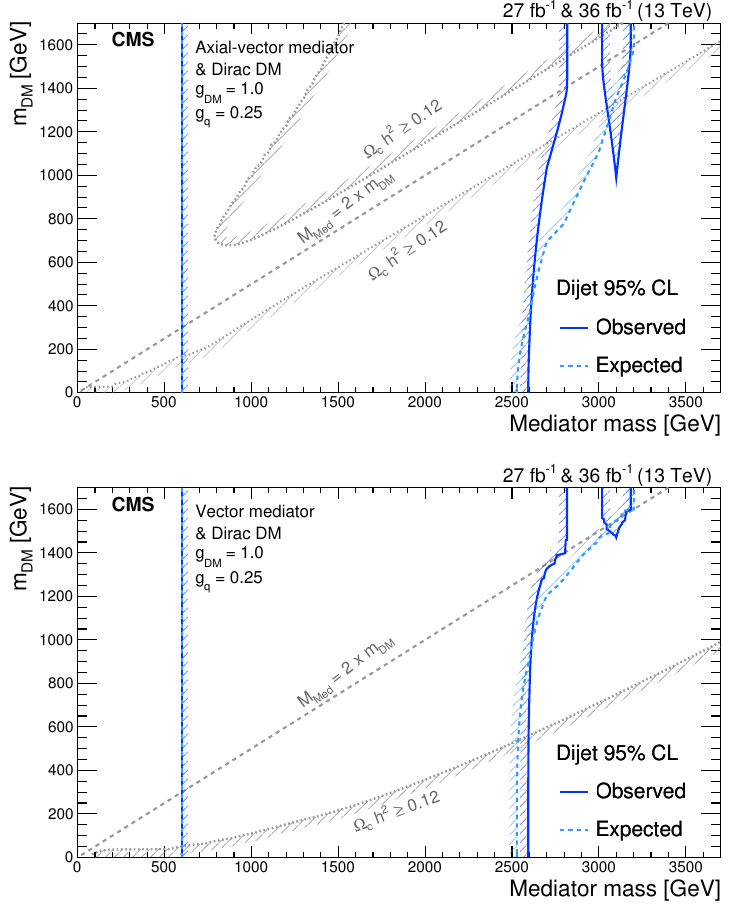
Figure 14 . The 95% CL observed (solid) and expected (dashed) excluded regions in the plane of dark matter mass vs. mediator mass, for an axial-vector mediator (upper) and a vector mediator (lower), compared to the excluded regions where the abundance of DM exceeds the cosmological relic density (light gray). Following the recommendation of the LHC DM working group [34, 35], the exclusions are computed for Dirac DM and for a universal quark coupling g q = 0 : 25 and for a DM coupling of g DM = 1 : 0. It should also be noted that the excluded region strongly depends on the chosen coupling and model scenario. Therefore, the excluded regions and relic density contours shown in this plot are not applicable to other choices of coupling values or